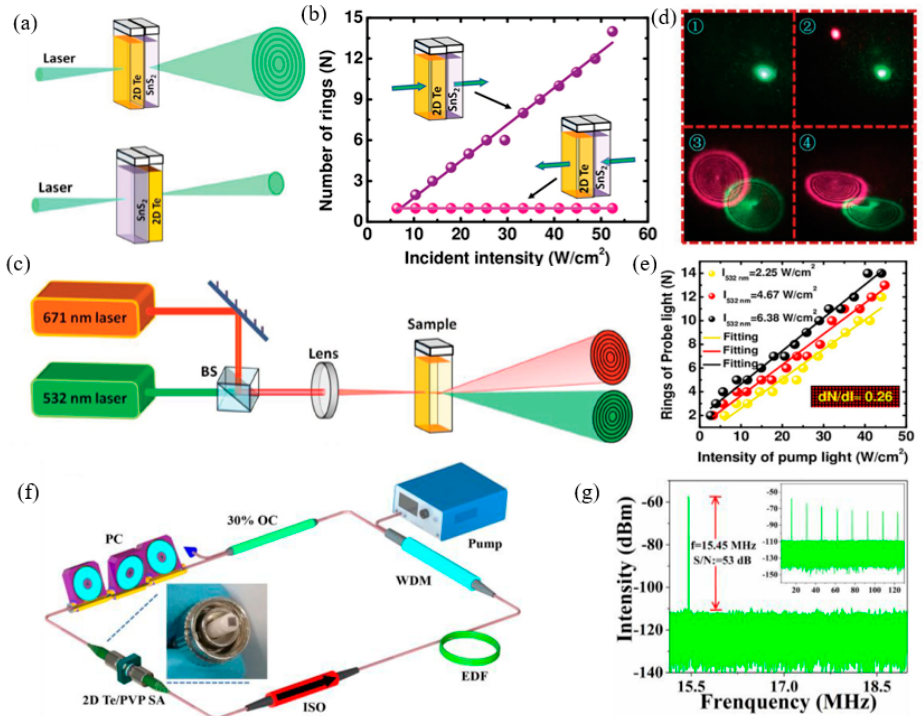
Figure 11. ( a ) The forward and reverse nonlinear responses of 2D Te/SnS 2 nanocrystalline photonic diodes. ( b ) Results of non-reciprocal propagation of light. ( c ) Schematic diagram of all-optical modulation structure. ( d ) Modulation of pump light (red light) to detect light (green light). ( e ) With the change of the light intensity of the pump, the change of the number of optical diffraction rings is detected [266]. Copyright 2019 Wiley-VCH Verlag. ( f ) Schematic of the mode-locking fiber laser. ( g ) Radio spectrum [265]. Copyright 2019 The Royal Society of Chemistry.